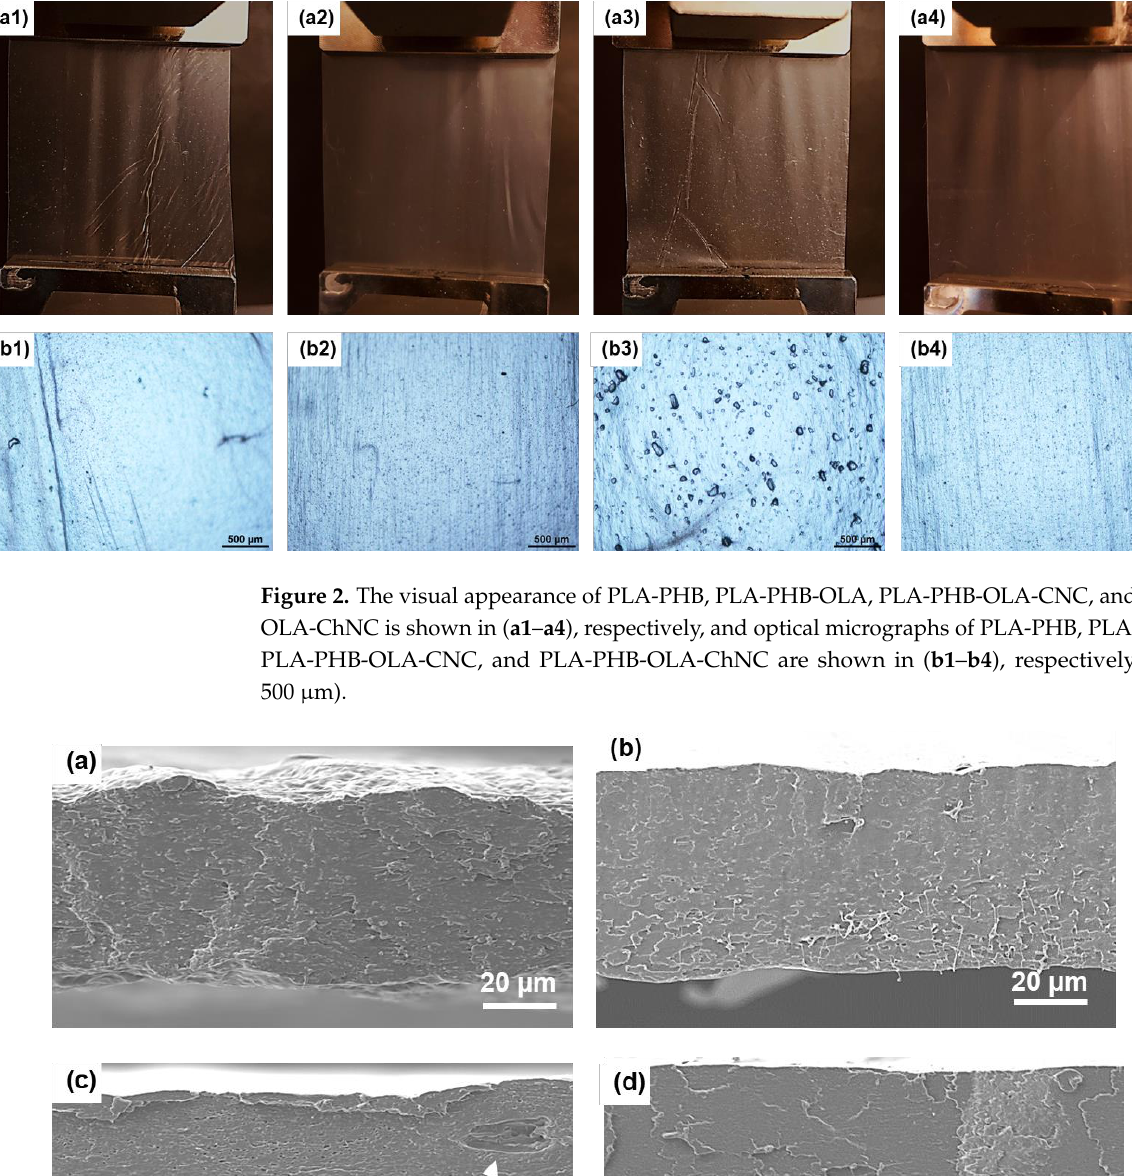
Figure 2. The visual appearance of PLA-PHB, PLA-PHB-OLA, PLA-PHB-OLA-CNC, and PLA- PHB-OLA-ChNC is shown in ( a1 – a4 ), respectively, and optical micrographs of PLA-PHB, PLA- PHB-OLA, PLA-PHB-OLA-CNC, and PLA-PHB-OLA-ChNC are shown in ( b1 – b4 ), respectively (scale bar 500 µm).